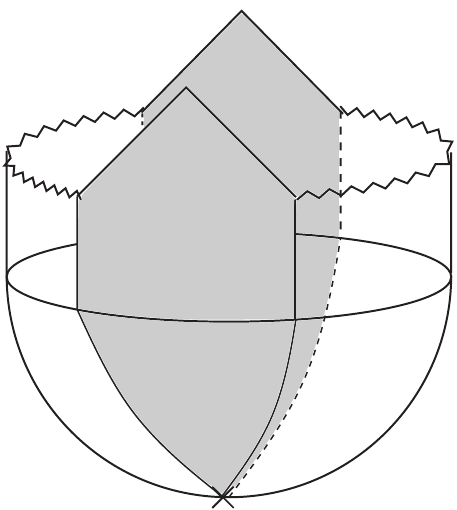
Figure 9. One could make the two-hat connected saddle dominate the path integral by freezing some portion of the geometry in the interior. A natural choice is to freeze all regions with some dilaton value φ ≥ 0 . Here we show the saddle where we have frozen everything filled in with gray. Note that when we include c/ ˜ φ r corrections to this solution then the frozen region actually includes a neighborhood of the conical